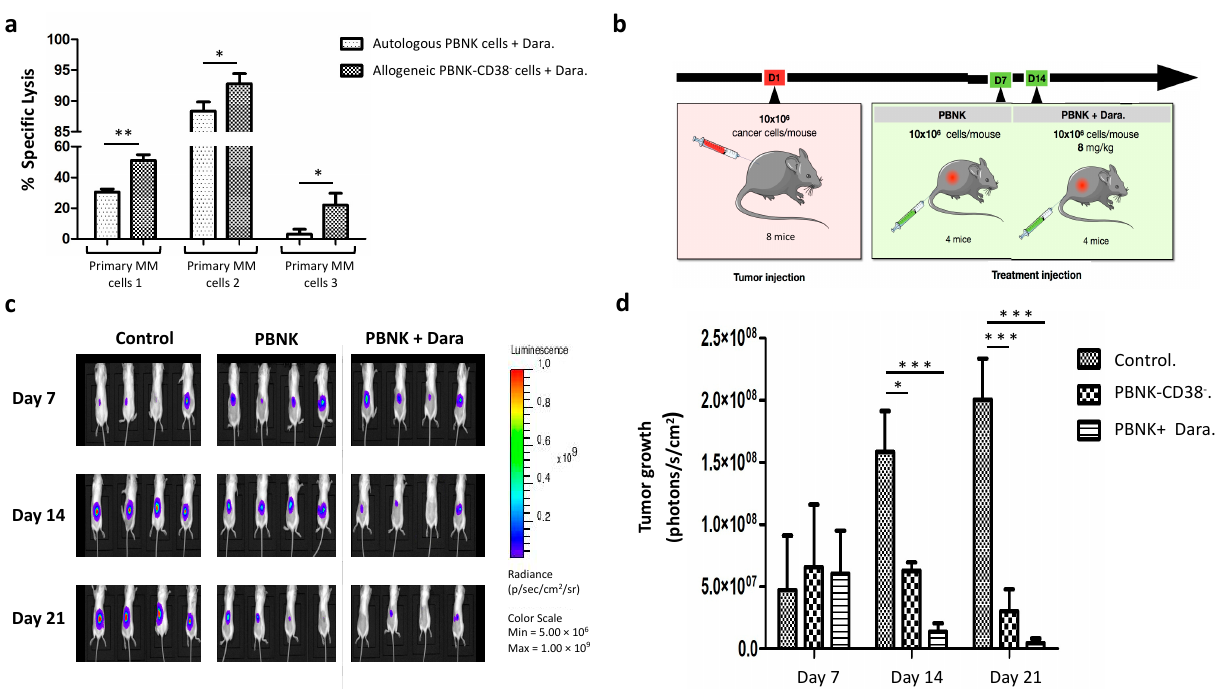
Figure 5. Combinatorial therapy in primary MM cells and in vivo mouse model of MM. ( a ) Graph with the specific lysis results in a combinatorial therapy with allogeneic PBNK-CD38 − and autologous PBNK cells against primary MM cells. Measured by flow cytometry at a 5:1 effector-to-target ratio for 4 h. ( b ) Schematic depiction of treatment regimen in the different groups. After tumor implantation on day 1, mice were divided into three groups: control group ( n = 4), single-agent treatment group with PBNK-CD38 − cells ( n = 4), and combo-treatment group with Daratumumab and PBNK-CD38 − cells ( n = 4). ( c ) Representative bioluminescence images in each group at 7, 14, and 21 after RPMI 8226 cell inoculation. ( d ) Summary graph with quantification of tumor growth over time ( n = 4 per group) by bioluminescence, demonstrating the higher inhibition of RPMI 8226 progression by the combinatorial therapy than control and single-agent groups. Data in ( a ) are presented as means ± SD from three technical replicates. Data in ( d ) are ± SEM. *, p < 0.05, **, p < 0.01, ***, p < 0.001, according to one-way ANOVA, repeated measures test, and Student’s t -test.